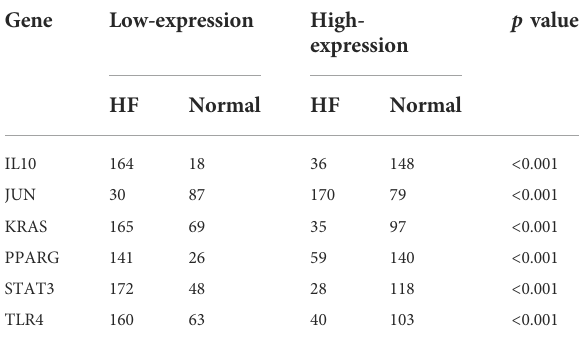
TABLE 3 The distribution of HF and normal individuals between the low- and high-expression group.